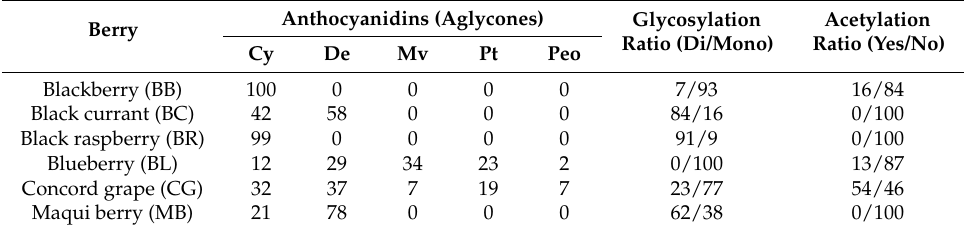
Table 2. Summary of anthocyanin diversity in whole freeze-dried berry powders (percent of total). Berry